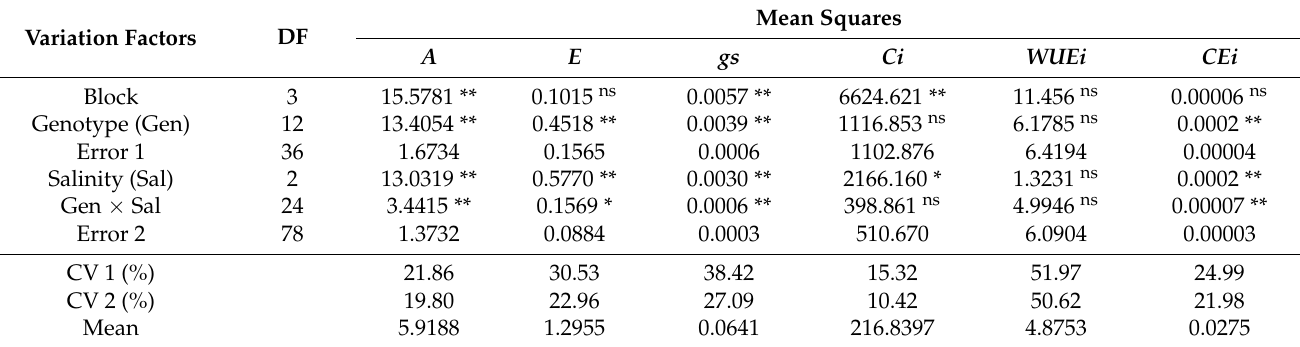
Table 8. Summary of analysis of variance of gas exchange—assimilation rate ( A ) ( µ mol m − 2 s − 1 ), tran-